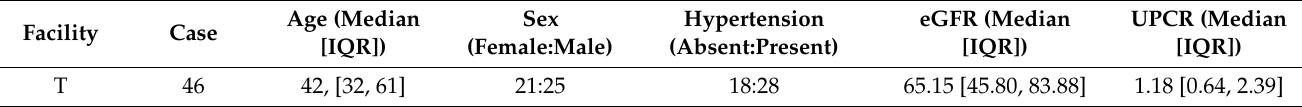
Table 2. Statistical summary of the patients with